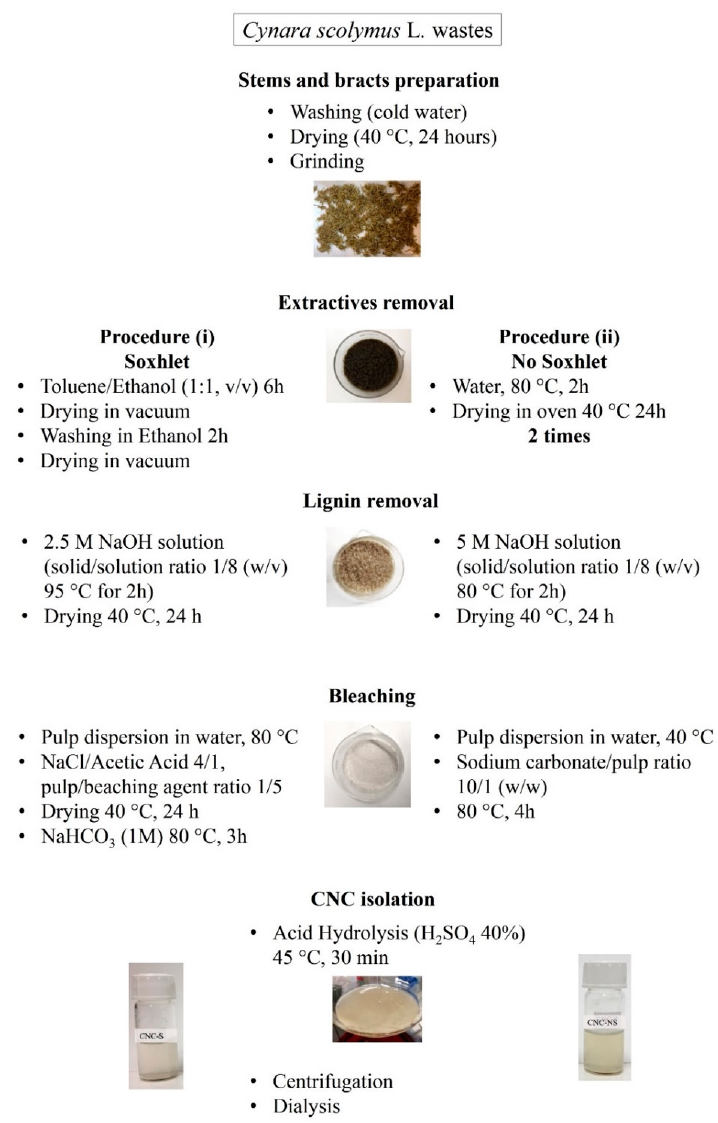
Figure 1. Representative scheme of the conventional (i) and innovative (ii) procedure to obtain CNC-S and CNC-NS, respectively.